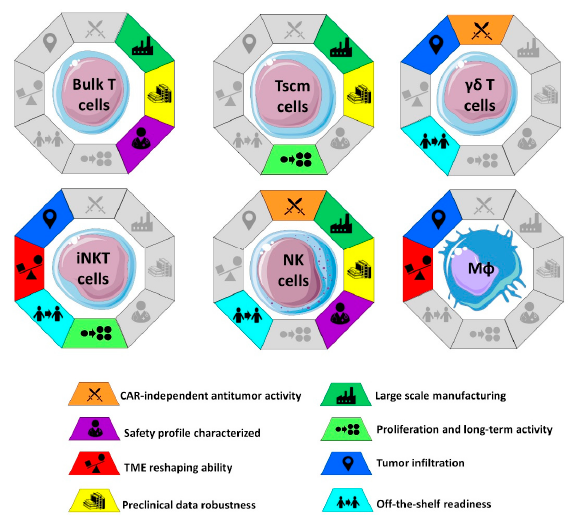
Figure 1. Characteristics of the different cells engineered with CAR constructs in solid tumors. As discussed in the main text, some of these characteristics can be acquired through additional gene manipulation. The Figure was partly generated using Servier Medical Art, provided by Servier, li- censed under a Creative Commons Attribution 3.0 unported